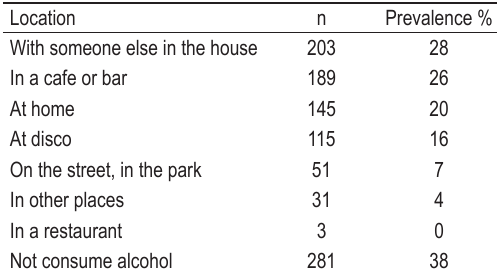
TABLE 2. The prevalence of alcohol use by location of consuming